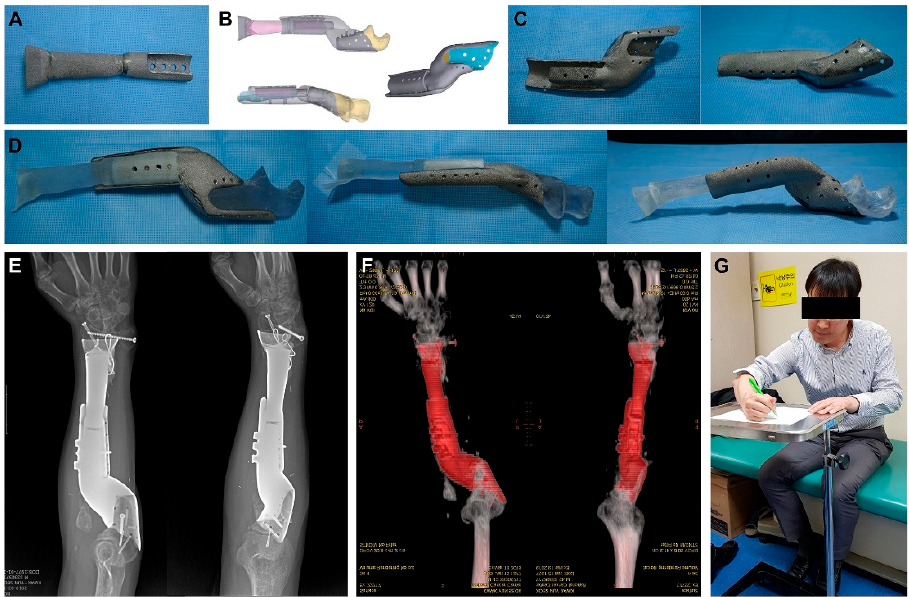
Figure 3. Revision limb salvage surgery using 3D-printed connector in the forearm. ( A ) A photograph of the previous 3D-printed implant for the radius. ( B ) Graphic designs of the 3D-printed connector and ( C , D ) photographs of the 3D-printed connector for single forearm bone surgery preserving the previous 3D-printed radial implant. Postoperative ( E ) plain radiographs and ( F ) computed tomography reconstruction images after second revision surgery using the 3D-printed connector. ( G ) A photograph showing functional position of the forearm during writing.